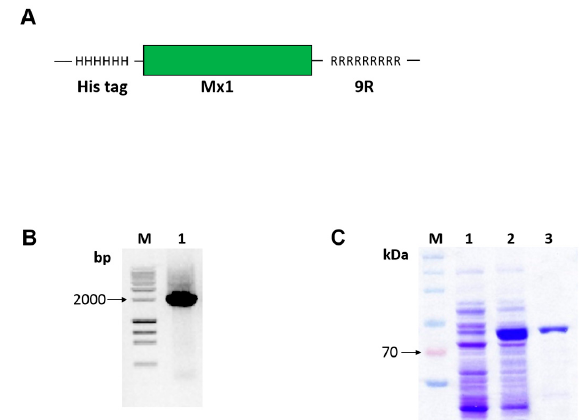
Figure 1. Construction, expression, and purification of cell-penetrating Mx1-9R. Escherichia coli cells were transformed with pET28a vector containing Mx1-9R fusion DNA sequence. After isopropyl β -D-1-thiogalactopyranoside (IPTG) induction, expressed Mx1-9R were purified by Ni-NTA column. ( A ) Structure of the Mx1-9R fusion protein was designed as described in the Methods. ( B ) Agarose gel electrophoresis of amplified Mx1-9R insert. ( C ) SDS-PAGE (2%) was performed to confirm the induction of Mx1-9R. BL21 (DE3). Lane 1: Whole lysates of control cells cultured without IPTG; lane 2: Whole cells induced with IPTG; lane 3: Purified Mx1-9R using Ni-NTA